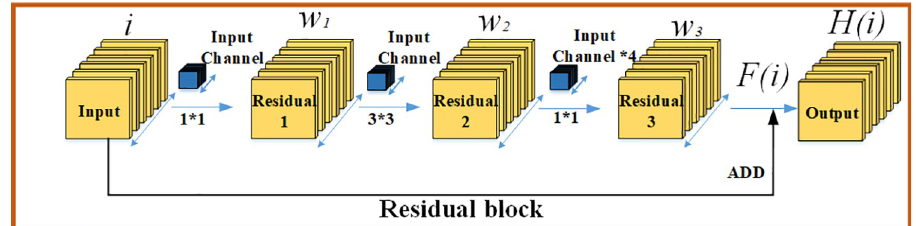
Fig 1. The structure diagram of residual. Residual network uses jump connection to construct residual structure, which solves the degradation problem to some extent.